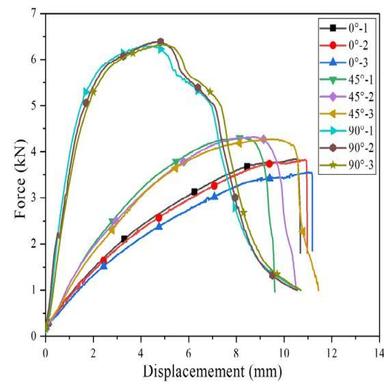
Geometrical sizes of the rivet.